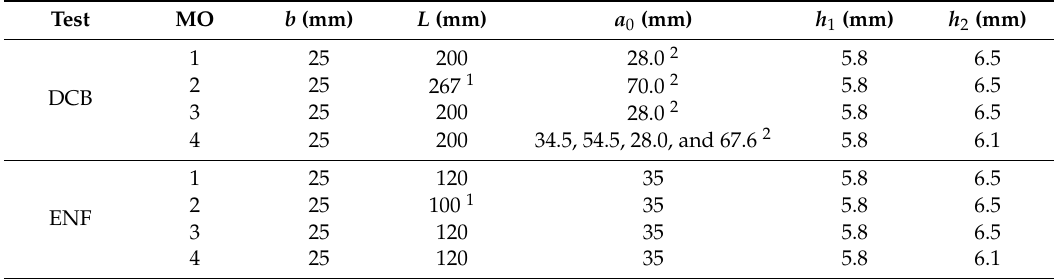
Table 2. Geometrical properties of the double cantilever beam (DCB) and end-notched flexure (ENF) test